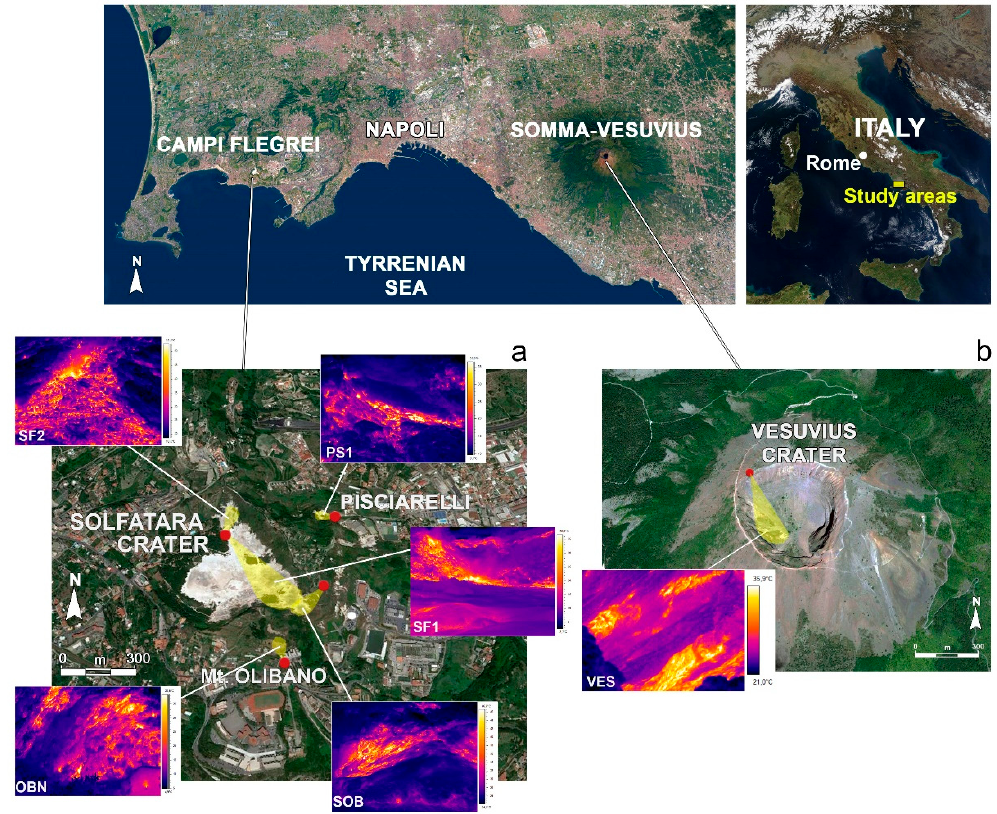
Figure 1. The Solfatara area ( a ) and Vesuvius crater ( b ) acquired by Thermel InfraRed Network (TIRnet) cameras. Red points are infrared (IR) stations locations and yellow regions represent the framed areas. 77